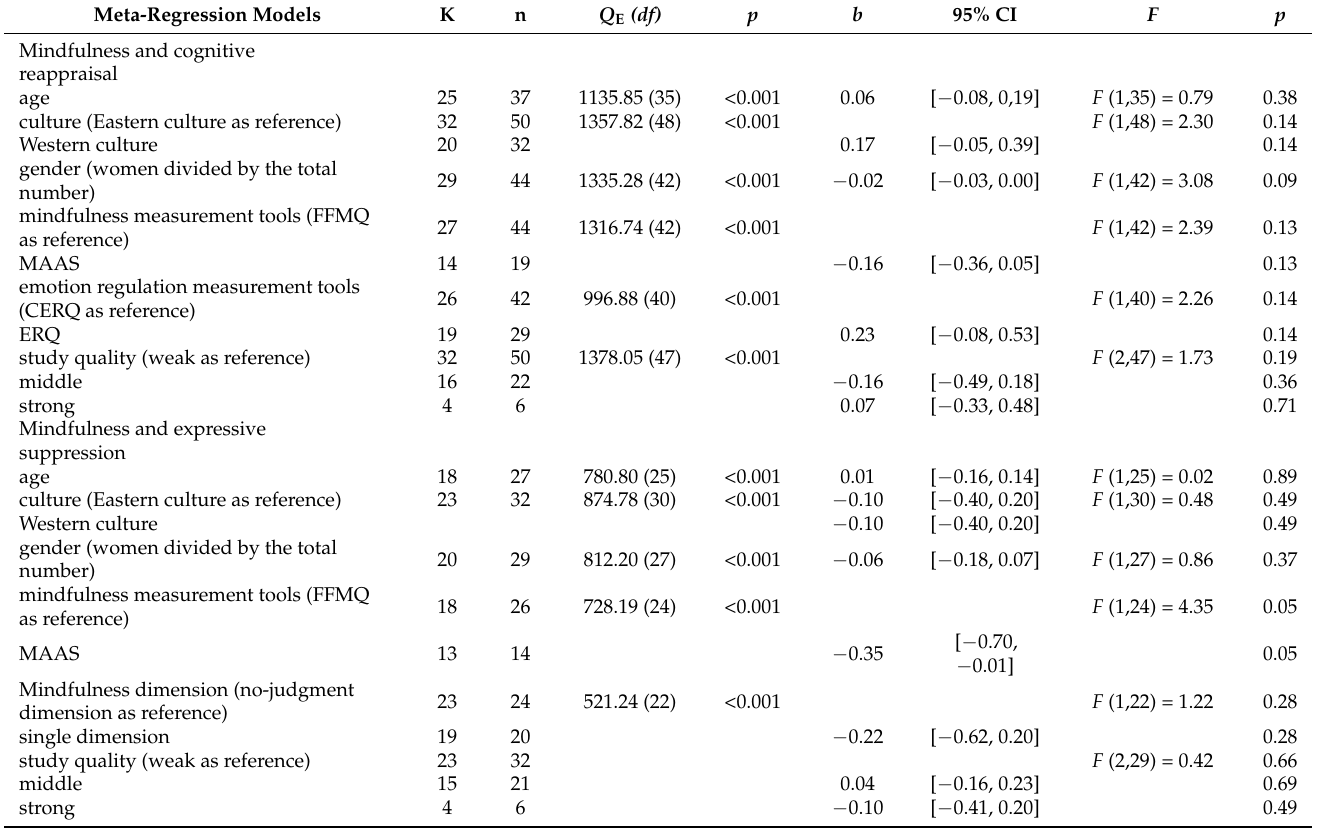
Table 3. Meta-regression